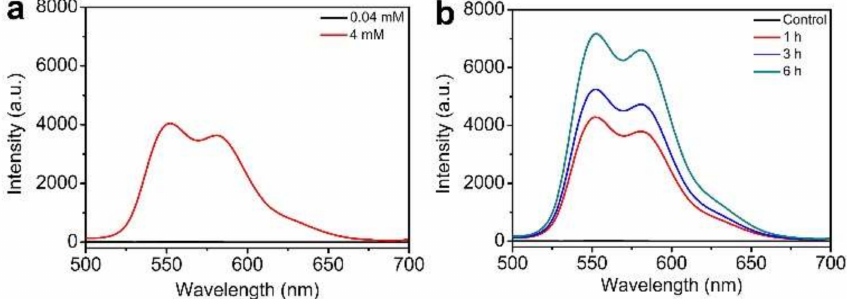
Figure 6. Fluorescence spectra of the supernatants resulted from interactions between DOX-labeled MSNs-SS-DMSA and varied concentrations of GSH for 1 h ( a ) and from interactions between the above labeling product and 4 mM of GSH ( b ) for different times.